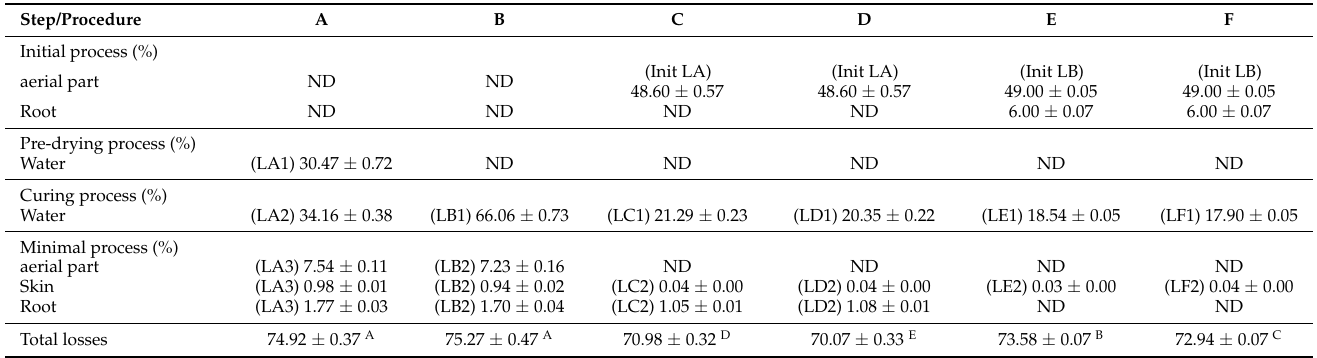
Figure 2. Postharvest process flow diagrams (PFDs) of raw material for black garlic (BG) processing. Postharvest procedure, including: A: garlic plants were sun-dried for seven days in the field before being combined and hung in the shade for 90 days; B: garlic plants are bundled together and hung in the shade for 90 days; C: garlic sample leaves are removed and then sun-dried on a grate for 14 days; D: garlic sample leaves are removed and dried on a grate in the shade for 14 days; E: all leaves and roots are removed from the garlic sample before sun drying on a grate for 14 days; F: all leaves and roots are removed from the garlic sample, which is then dried on a grate in the shade for 14 days; LA, LB, LC, LD, LE, and LF are the losses detected in the postharvest procedures A, B, C, D, E, and F, respectively. Table 1. The mass flow of garlic loss during postharvest handling of Thai garlic.